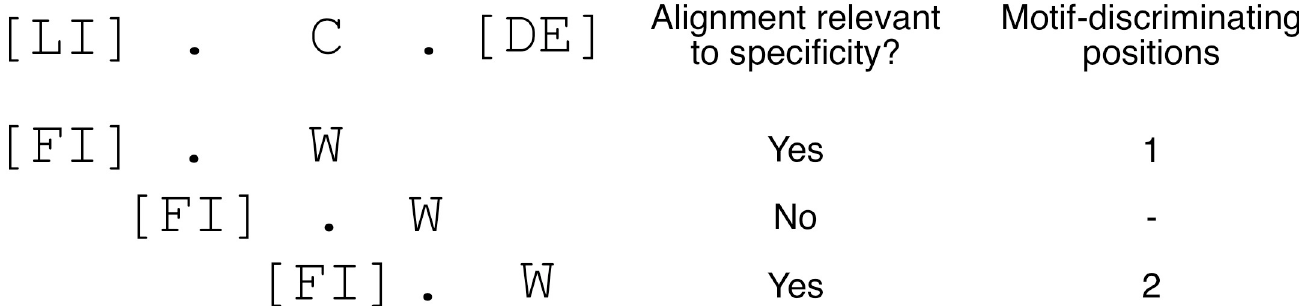
Fig 3. Measurement of the distance in sequence space between a pair of linear motif classes. We illustrate the calculation for the regular expressions [LI].C.[DE] and [FI].W. Due to the different lengths of the two regular expressions there are three possible alignments, all of them hanging ends that belong to the longer regular expression. The second alignment does not match a pair of fixed positions and does not help us test the distance in sequence space between the two motifs. The first and third alignments match two pairs of fixed positions each. For each of them, we count the number of motif-discriminating positions where no amino acid can match both regular expressions. The result is one for the first alignment and two for the third alignment. We take the minimum of these two figures. Thus, the distance in sequence between these two linear motif classes is of at least one motif-discriminating position.